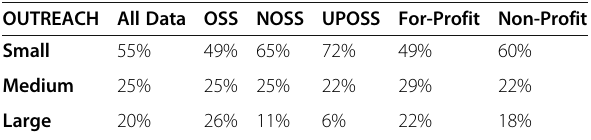
Table 1 Comparison of Outreach amongst different types of MFIs